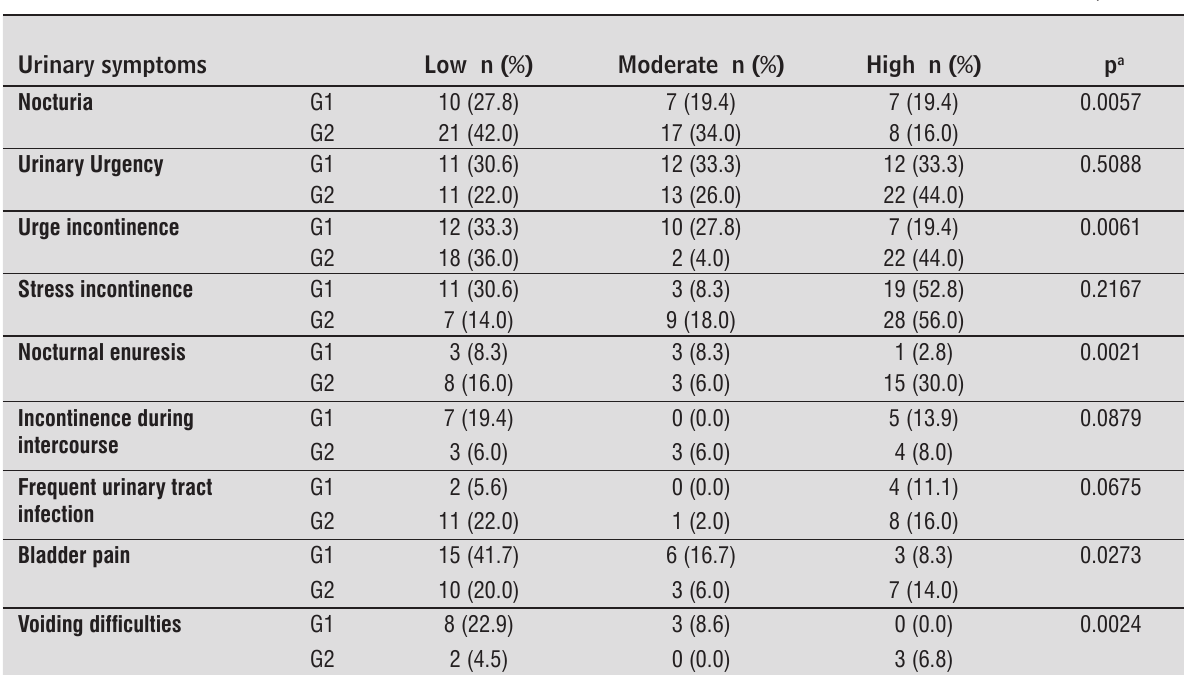
Table 3 - Urinary symptoms scale by King’s Health Questionnaire (KHQ) in women on reproductive age (G1) and on post- menopausal period